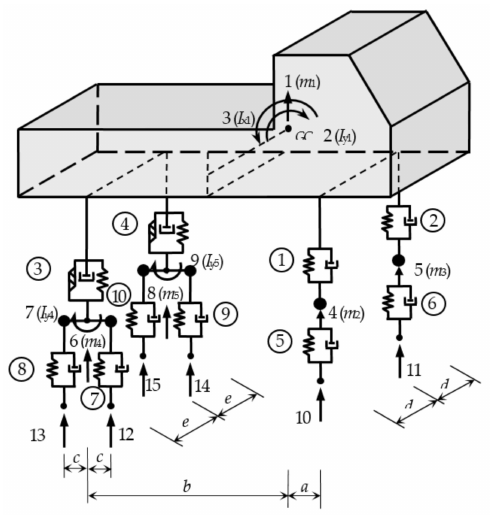
Figure 1. Computational model of